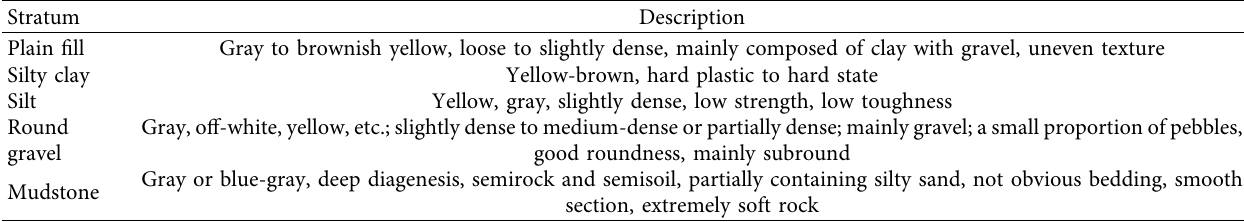
Figure 1: Subway tunnel section of upper and lower overlapping sections (unit: Table 1: Strata in subway tunnel section of upper and lower overlapping sections.